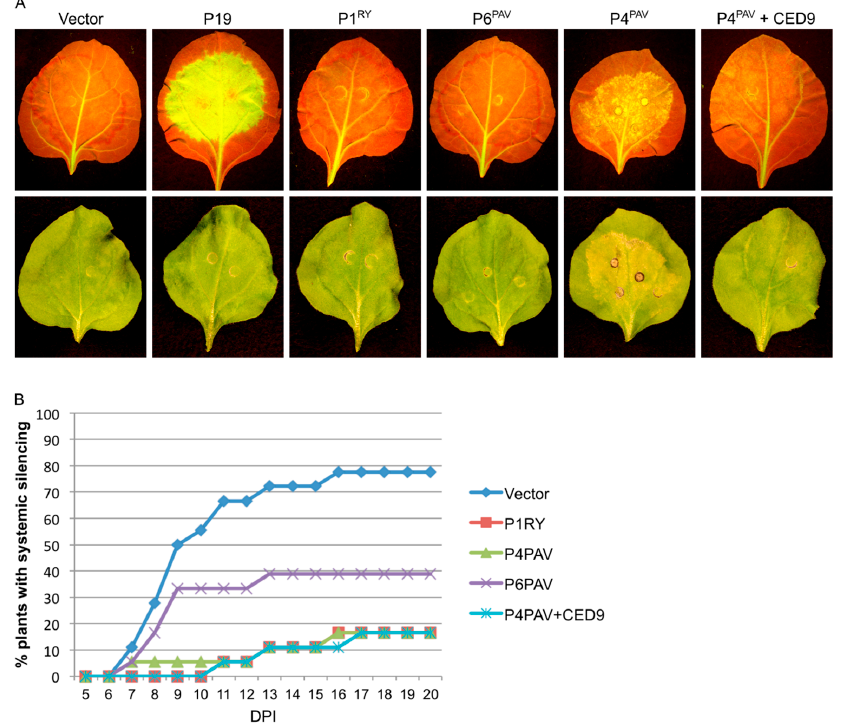
Figure 3. Inhibition of necrosis does not affect BYDV-PAV P4 local and systemic silencing suppression